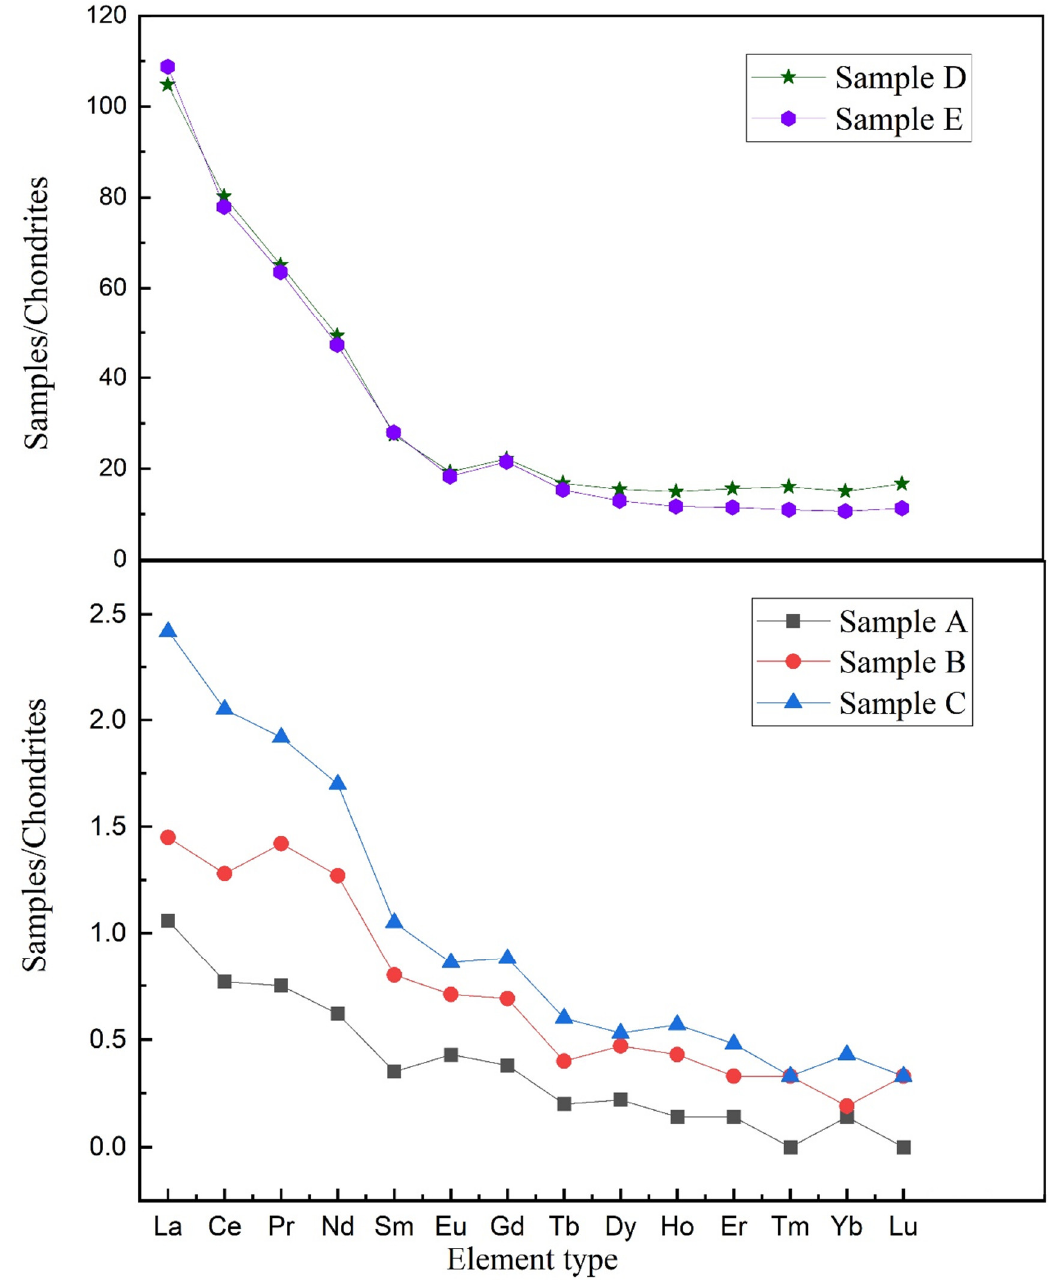
Figure 9. REE distribution patterns normalized to spheroid meteorites from the Mayuan Zn-Pb ore and black shale.